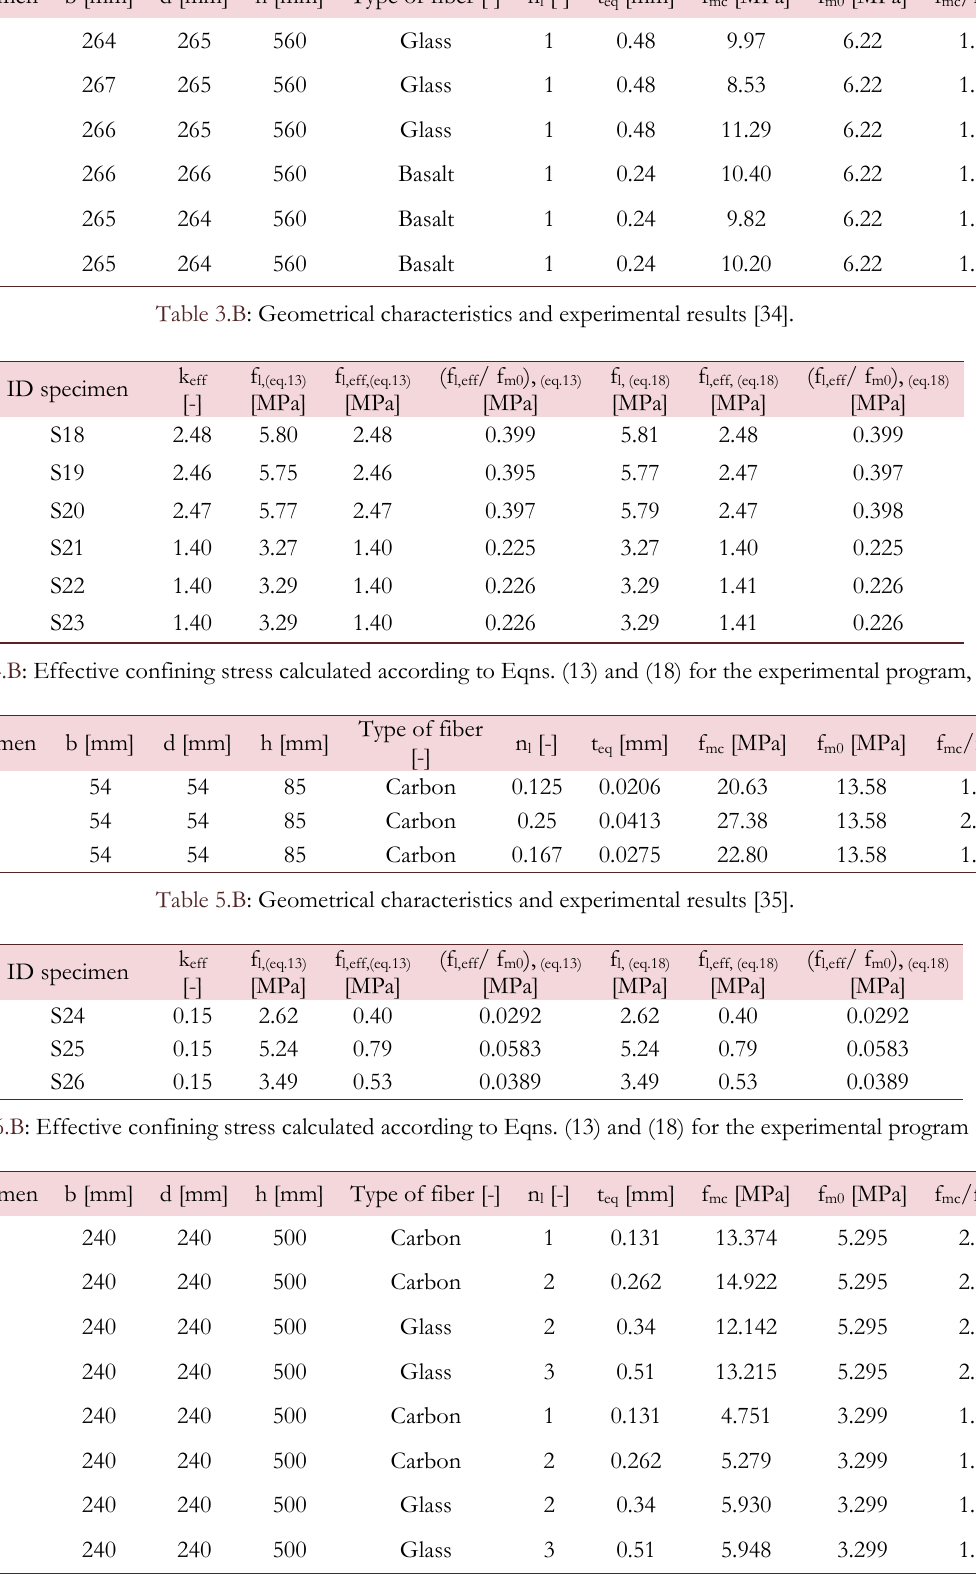
Table 7.B: Geometrical characteristics and experimental results